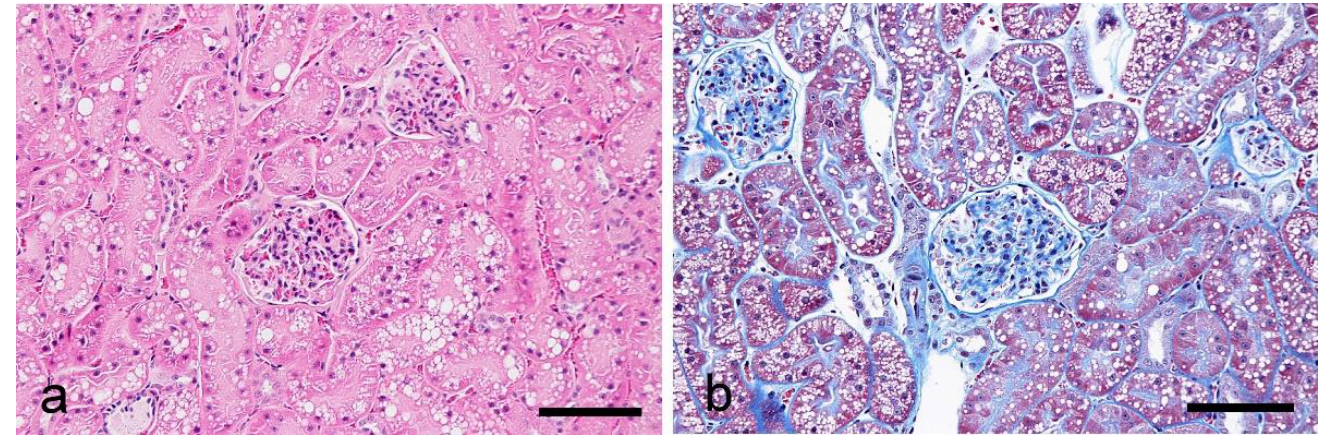
Figure 1. Histological findings of the cortex in the feline kidney. ( a ) HE stain, ( b ) MT stain. Scale bars 100 μm.